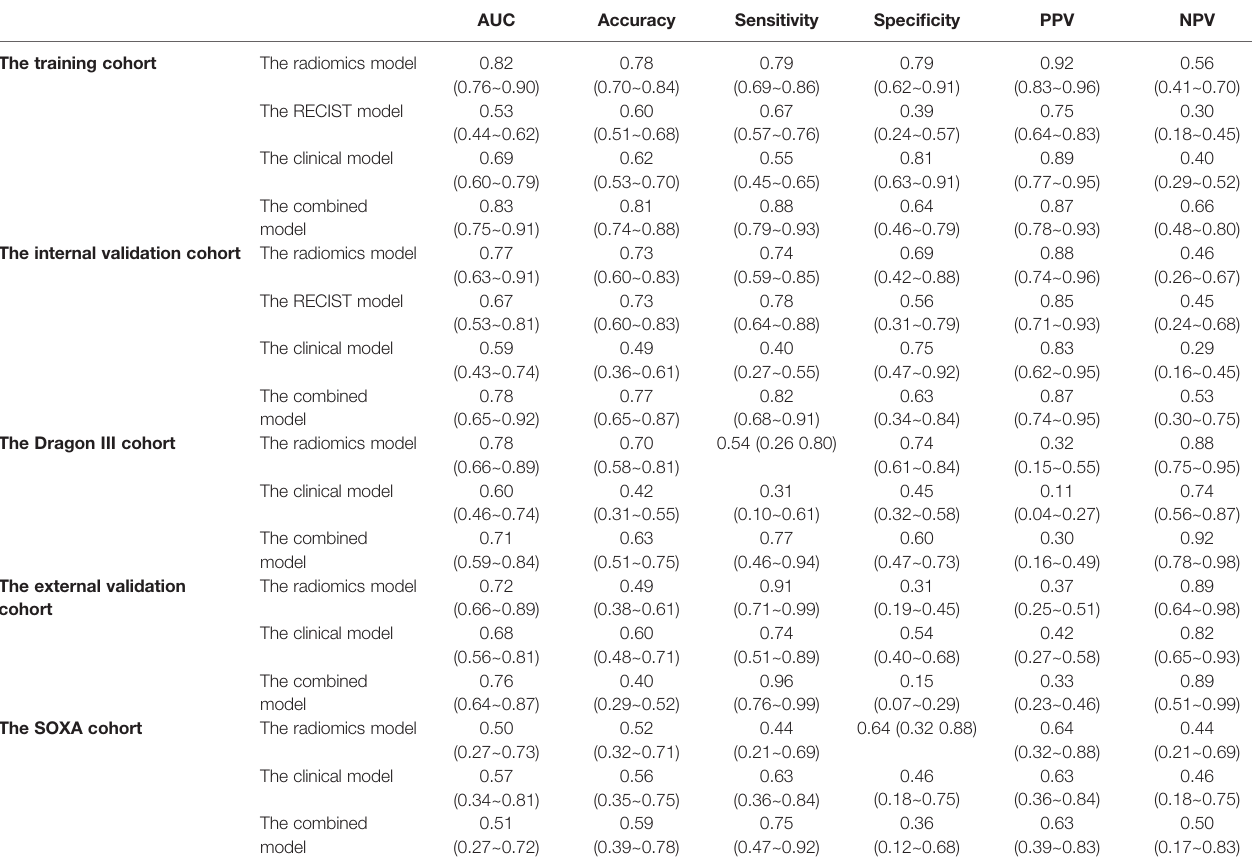
TABLE 2 | Performance of different models in each